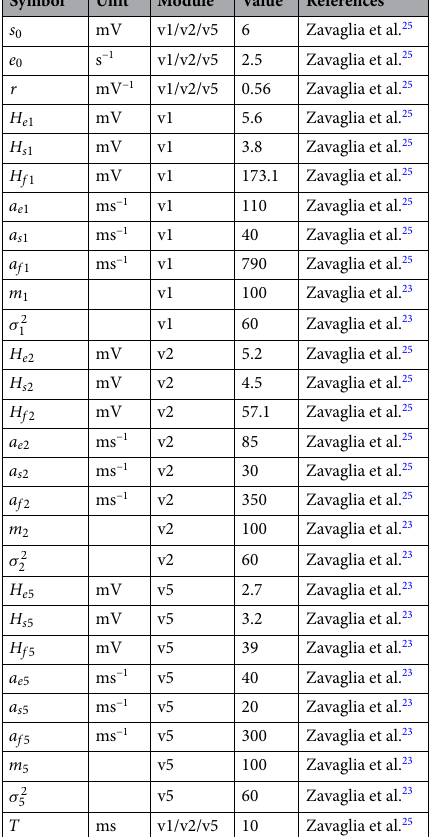
Table 2. Other basal parameters in the model of dorsal visual pathway.